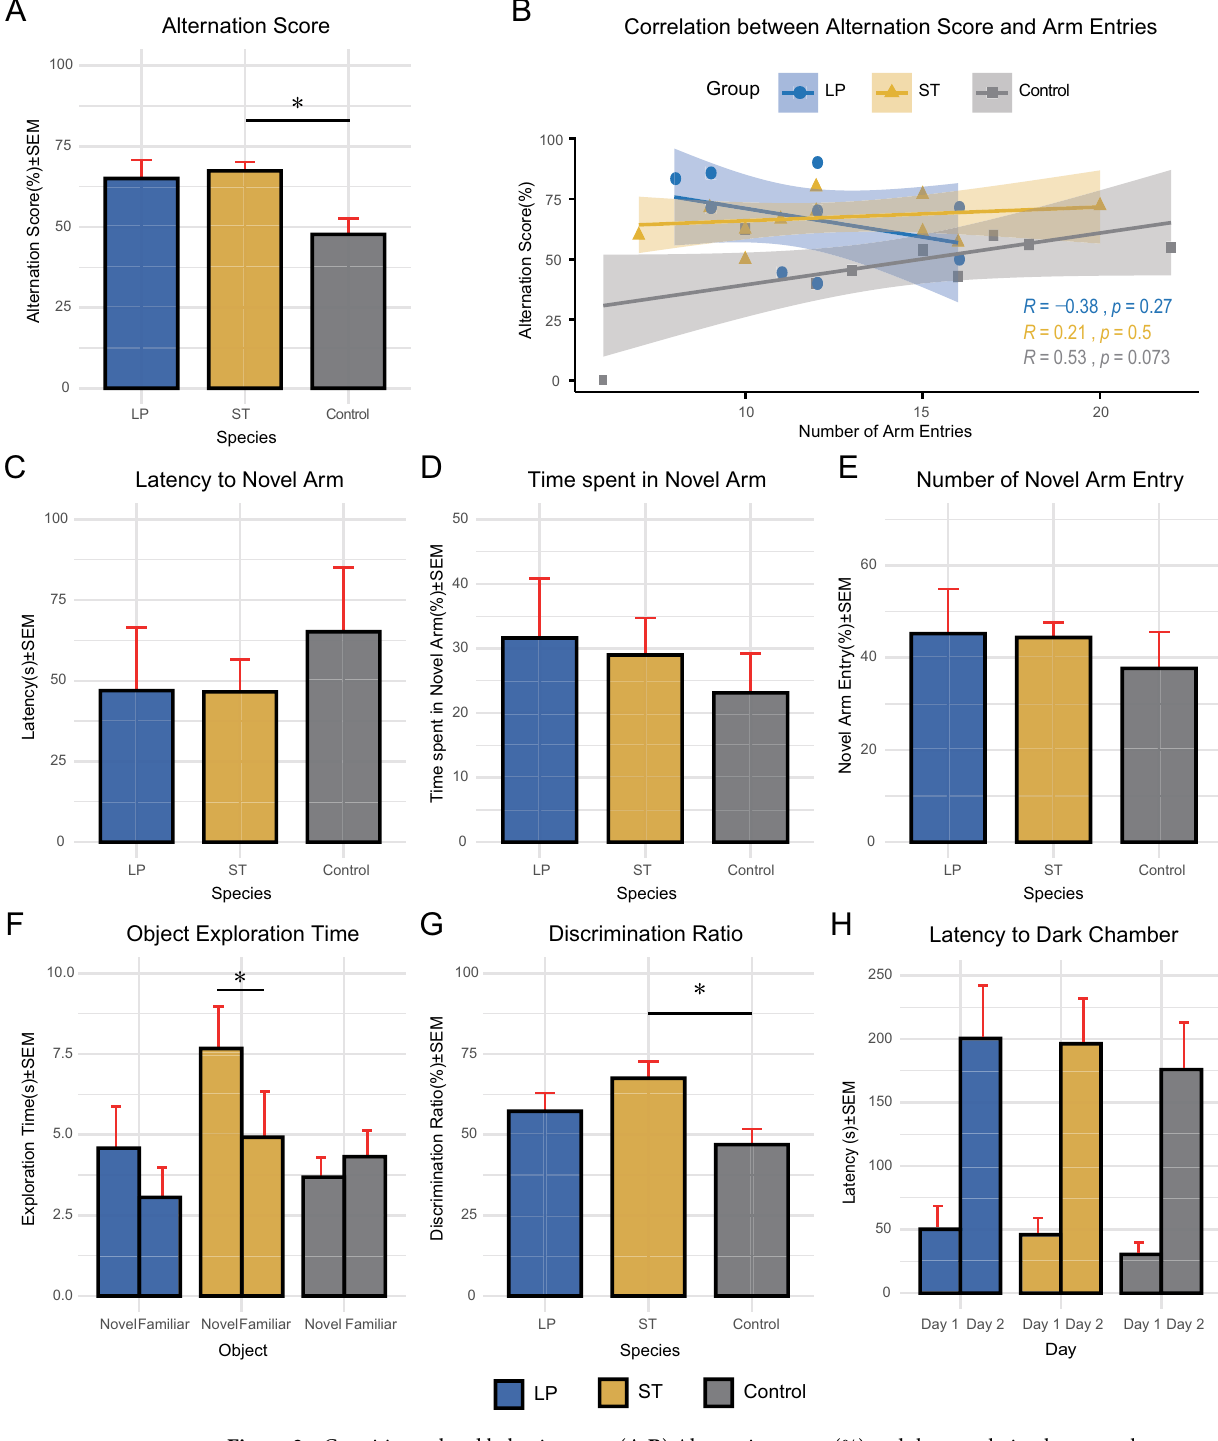
Figure 2. Cognition-related behavior tests. ( A,B ) Alternation score (%) and the correlation between the alternation score and a total number of arm entries of Y-maze spontaneous alternation test. ( C–E ) Latency to novel arm (s), time spent in the novel arm (%), and a total number of novel arm entries (%) in Y-maze forced alternation test. ( F,G ) Time spent in exploration of novel and familiar objects (s) and discrimination ratio (%) in the novel object recognition test. ( H ) Latency to dark chamber (s) on day1 (training session) and day 2 (testing session) of passive avoidance test. All data were expressed as mean ± standard error of the mean (SEM). Differences between the mean values were tested using one-way analysis of variance (ANOVA) or Kruskall- wallis test, where appropriate, followed by the Tukey’s post‑hoc test. Correlations were assessed by Pearson’s statistics. The difference was considered statistically significant when P -value < 0.05 (indicated with